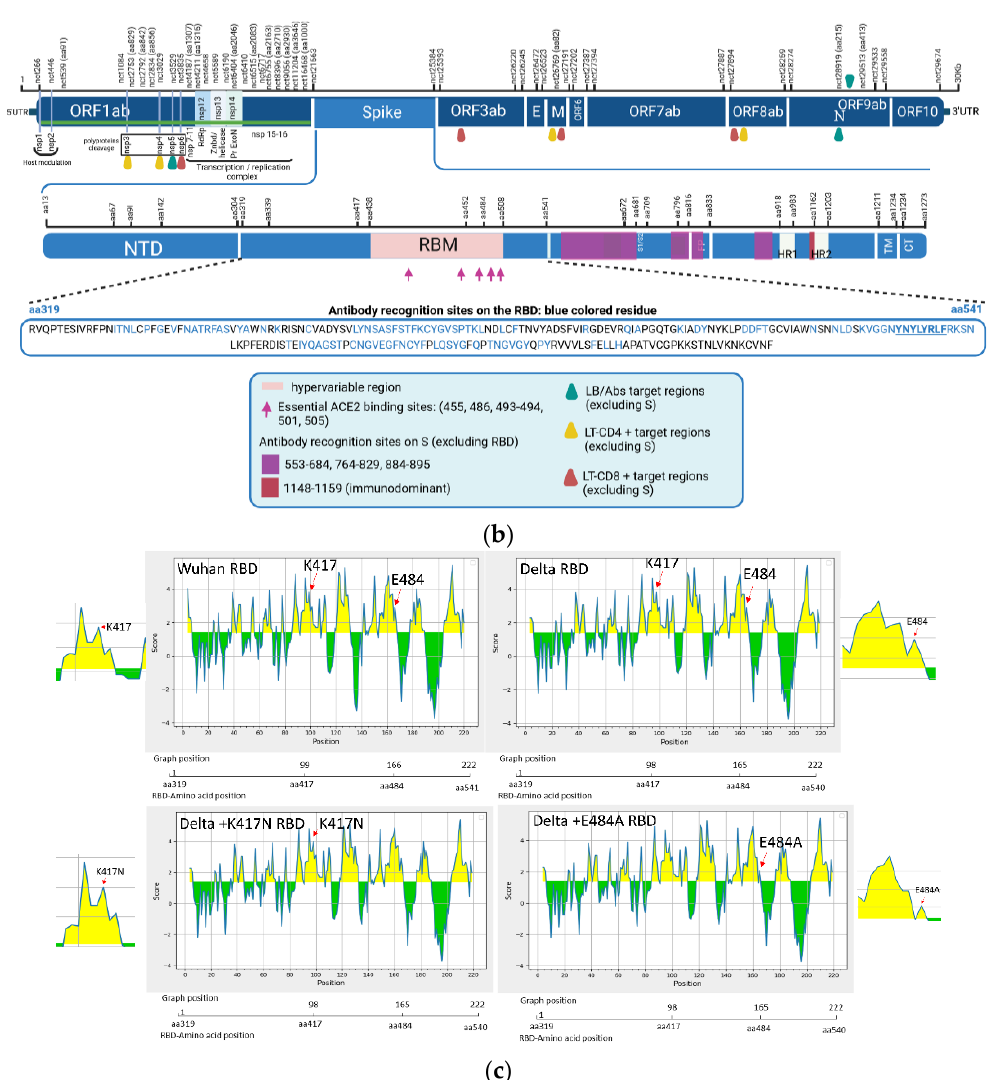
Figure 1. Tracking the Delta Omicron shift and its functional prediction impact. ( a ) SARS-CoV-2 temporal variability (University Hospital-UH Nancy/France) compared to that in France (Santé publique) from October 2021 to April 2022 (curves). Percentage of Omicron and Delta sequences in UH-Nancy from November 2021 up to April 2022 (bars). ( b ) The mapping of some molecular signatures of variant mixtures and/or recombinants from all clinical and WW samples (E1–10 and WW1–WW4), localized mutations on the map; the peptide used in MHC-I binding prediction is underlined in the RBD sequence (EPI ISL 402124) (biorender). aa: amico-acid position; nct: nucleotide